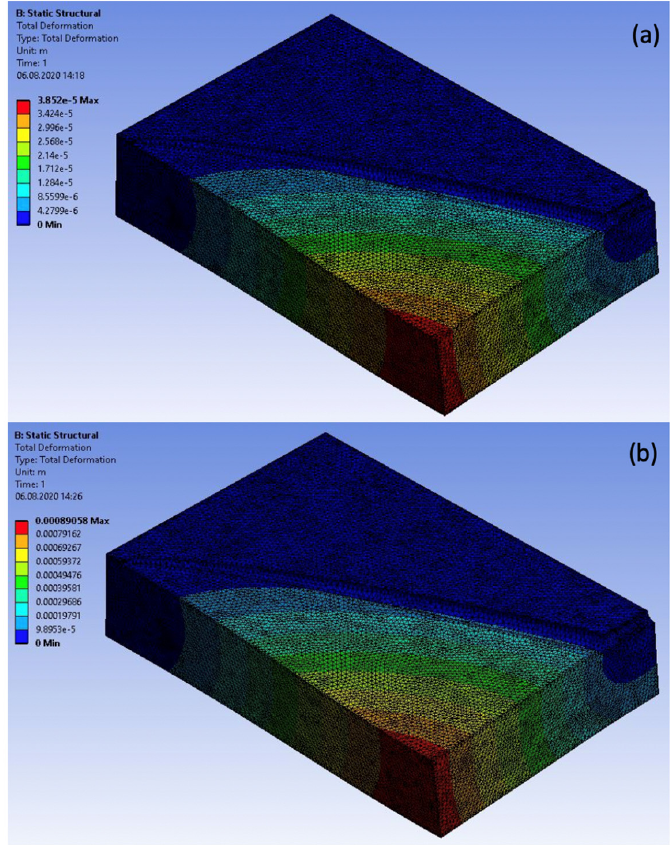
Figure 9. Deformation contour plots of extrusion: ( a ) material #2 and ( b ) material #3. Table 5. Ratio of the maximum deformation value to the thickness of the solid die body.